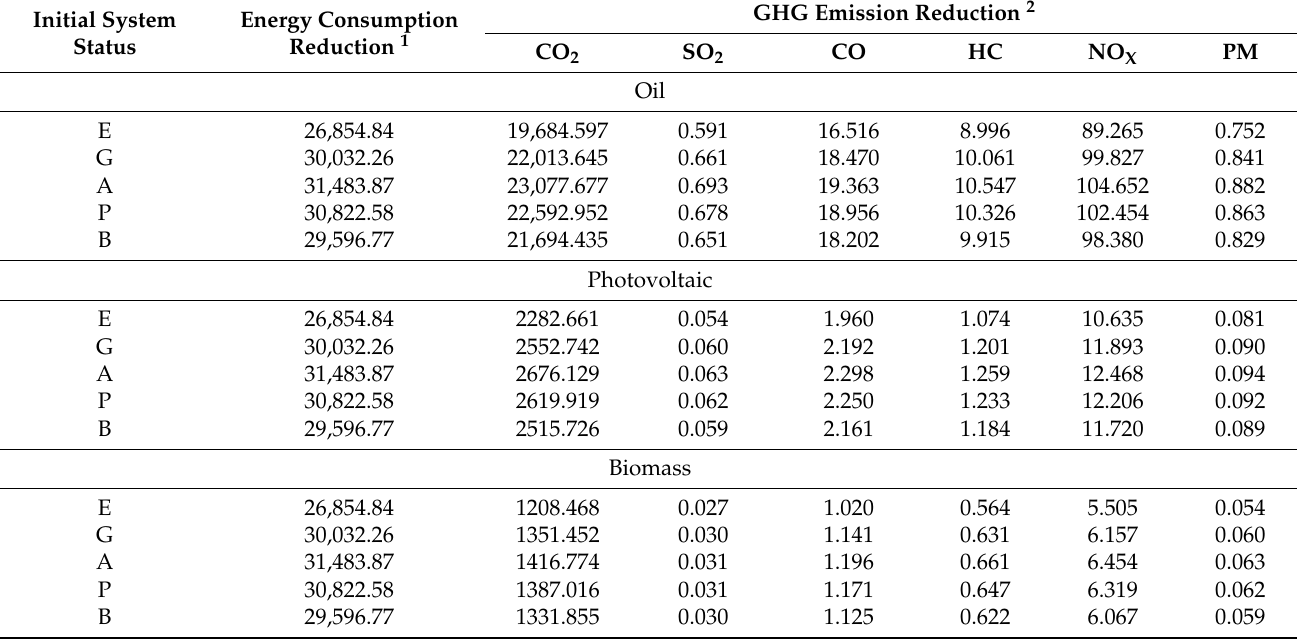
Table 12. Energy consumption reduction and GHG emission reduction resulting from the first iteration of maintenance policy optimization within the whole time-window of analysis in the case of electricity generation source oil, photovoltaic, and